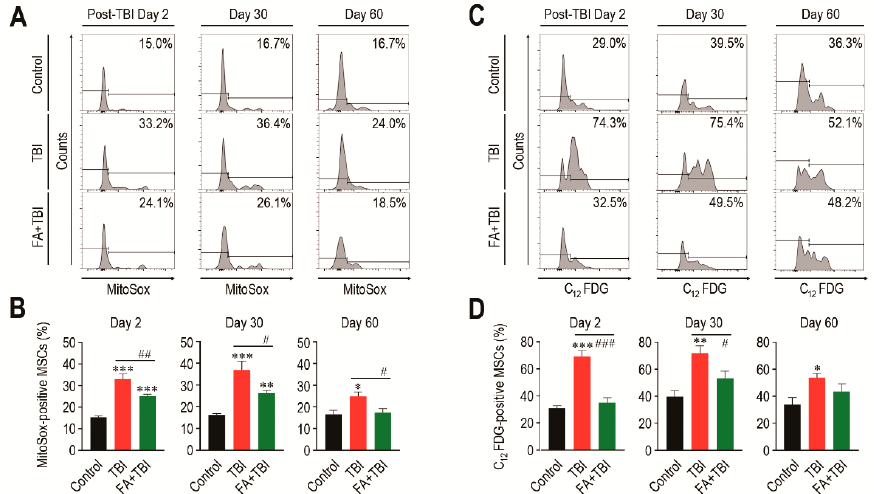
Figure 2. Supplemental ferulic acid inhibits TBI-mediated increases of ROS accumulation and se- BM-conserved MSCs. ( A , B ) Level of mitochondrial superoxide anions in BM MSCs from mice groups were assessed by flow cytometry using MitoSox TM Red reagent at the indicated days after TBI ( n = 4). ( C , D ) SA- β -gal activity in BM-conserved MSCs from mice groups was also measured by flow cytometry using C 12 FDG at the same post-TBI days ( n = 4). All data are presented as the mean ± SD. * p < 0.05, ** p < 0.01, and *** p < 0.001 compared with control group; # p < 0.05, ## p < 0.01, and ### p < 0.001 compared with TBI